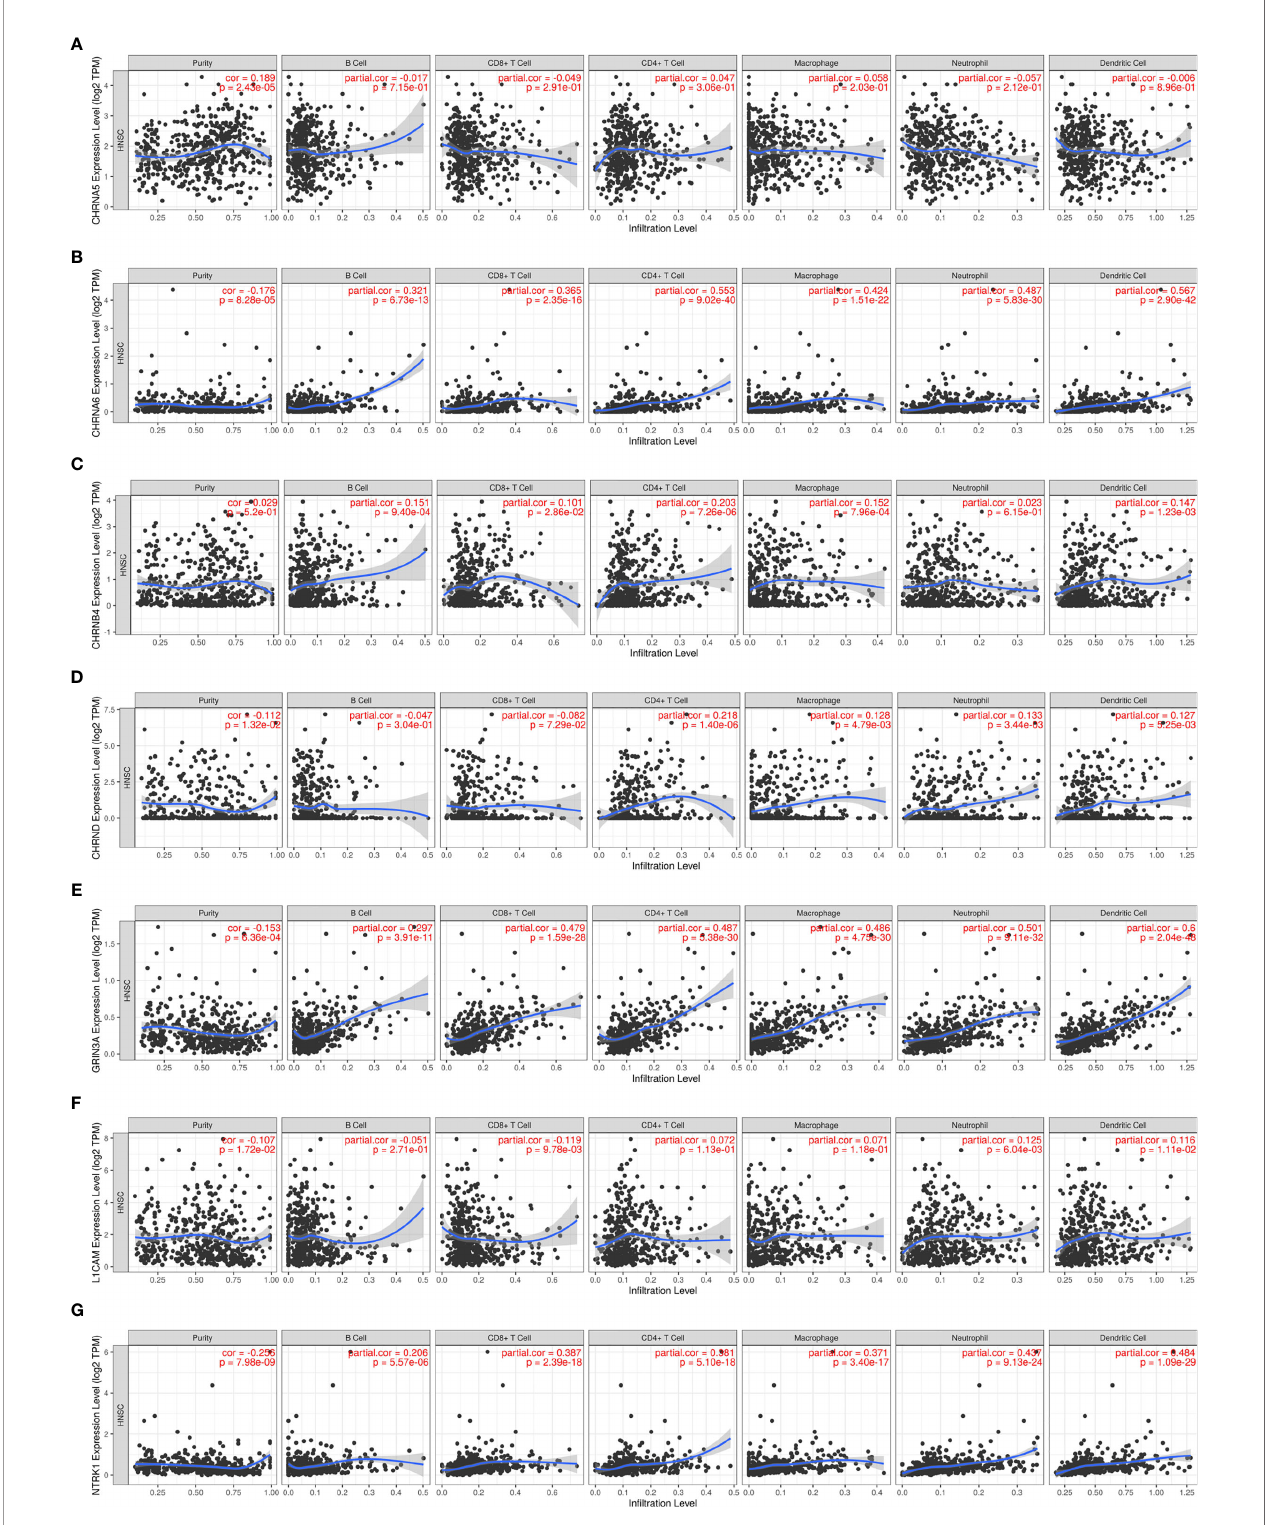
FIGURE 6 | The association between seven prognostic NCCGs and immune in fi ltration. The association between the abundance of immune cells and the expression of CHRNA5 (A) , CHRNA6 (B) , CHRNB4 (C) , CHRND (D) , GRIN3A (E) , L1CAM (F) , and NTRK1 (G) in HNSC. NCCGs, nerve-cancer cross-talk genes; HNSC, head and neck squamous cell